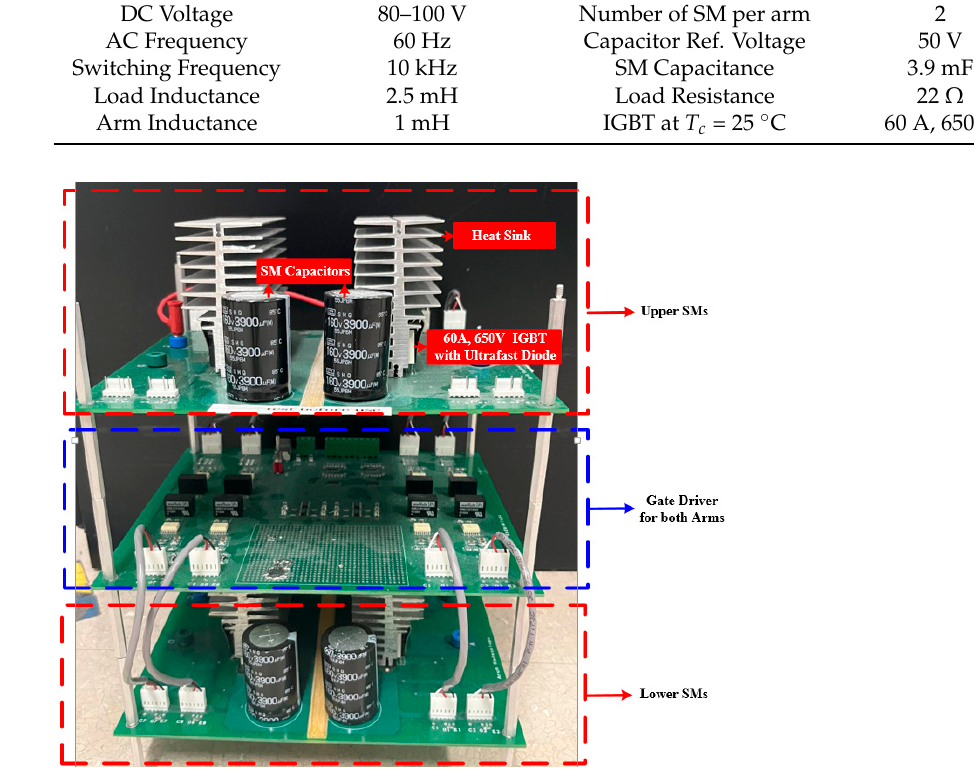
Figure 12. A phase leg of the MMC prototype.